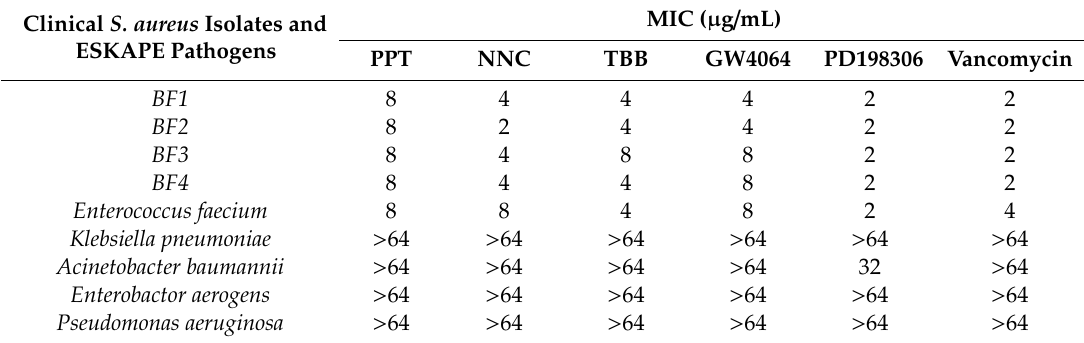
Table 4. Antibacterial activity of compounds against clinical S. aureus isolates and ESKAPE pathogens. Clinical S. aureus Isolates and